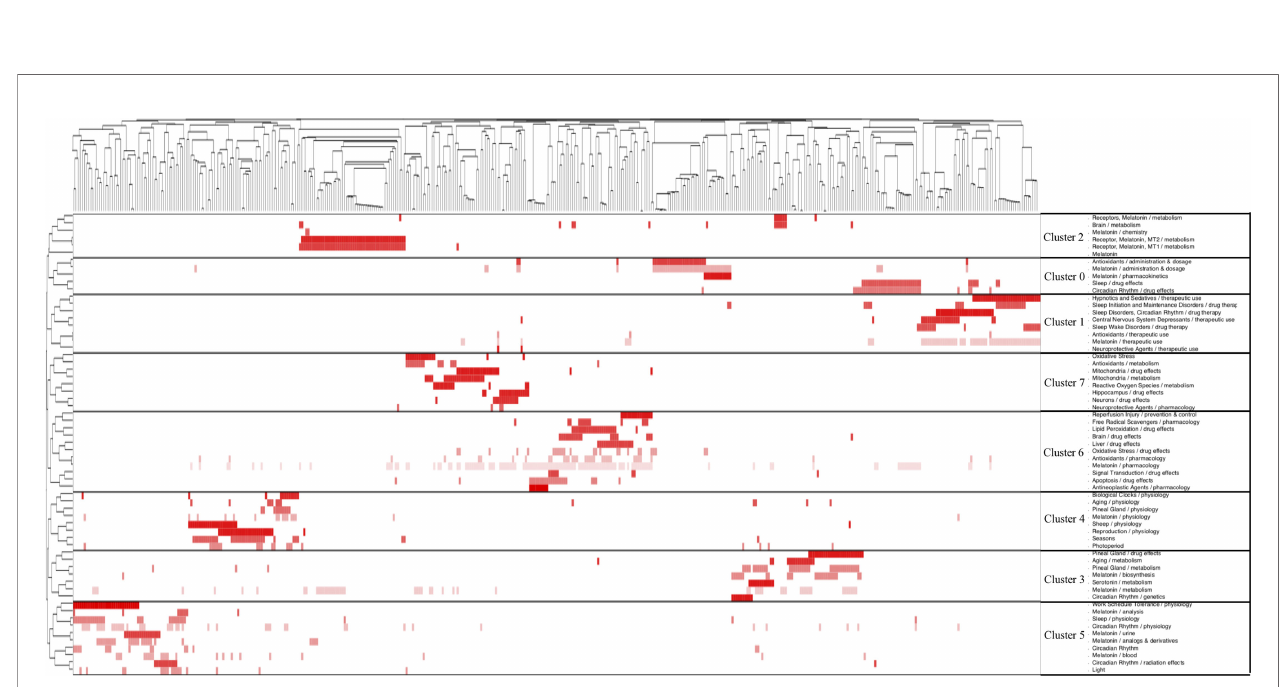
FIGURE 6 | Visualized matrix of the MeSH terms and source